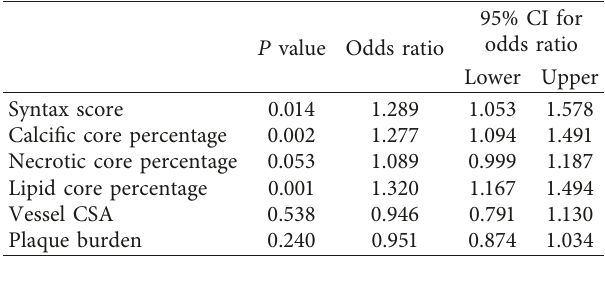
Figure 2: IVUS runs of LAD lesions. (a) Greyscale run of SA patient. (b) iMAP study of lesion in (a). (c) Greyscale run of NSTE-ACS patient. (d) iMAP study of lesion in (c). Green � fibrous component. Yellow � lipid component. Red � necrotic component. Blue � dense calcium. Table 5: Predictors of NSTE-ACS.